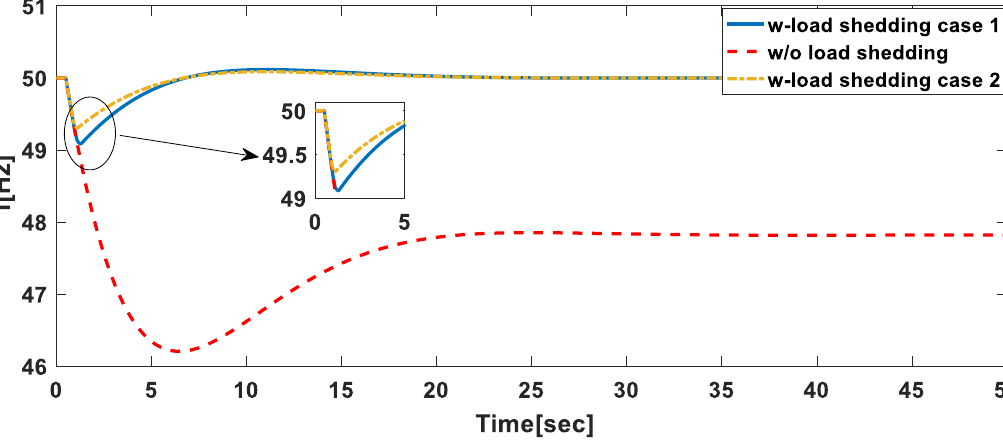
Figure 6. Frequency behavior in the first scenario: a comparison between cases 1 &